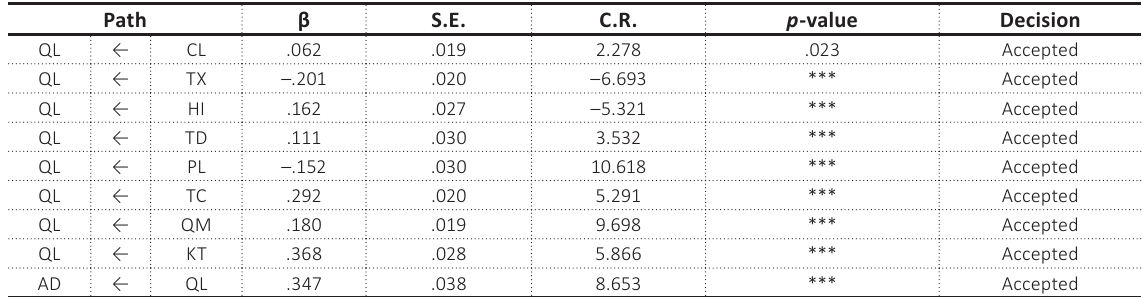
Table 4. Hypotheses